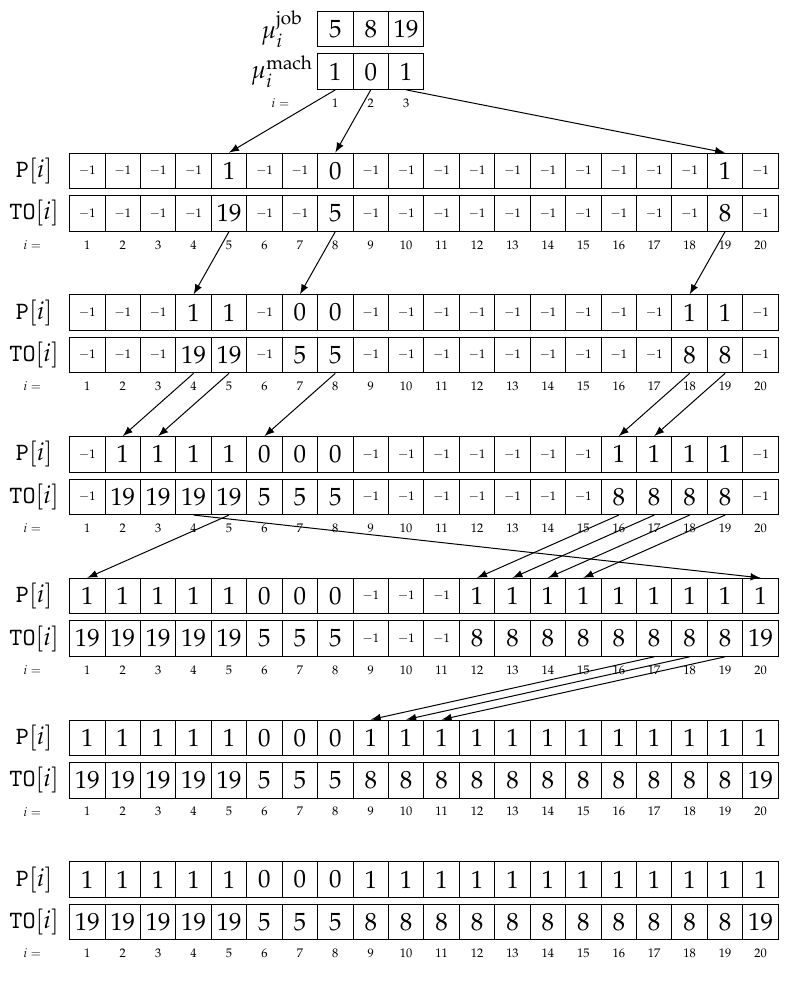
Figure 4. Memory during computations in Algorithm 2 for n = 20 and µ = (( 5,2 ) , ( 8,1 ) , ( 19,2 ))